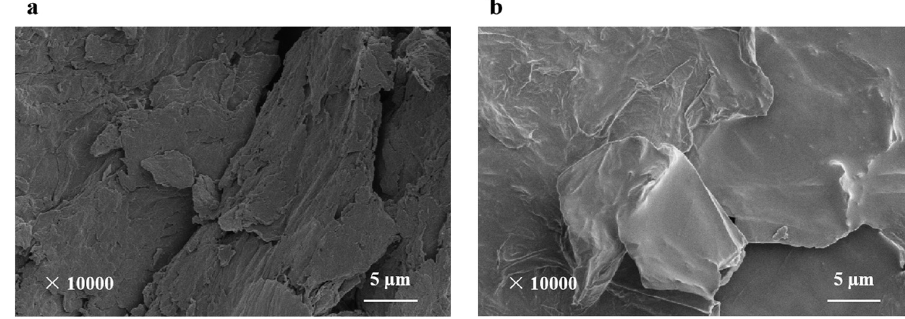
Figure 6: SEM images of GO: ( a ) before ultrasonic dispersion and ( b ) after ultrasonic dispersion for 3